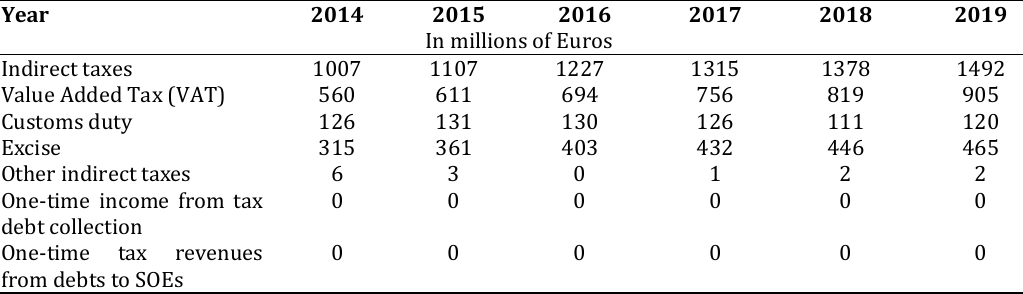
Table 4: Indirect taxes in Kosovo (2014-2019)